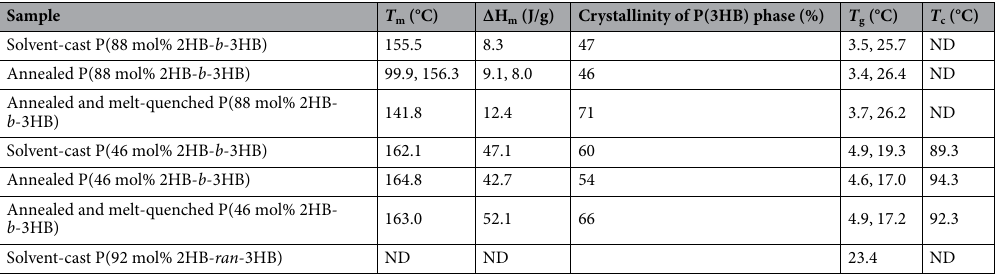
Table 2. Thermal properties of P(2HB- b -3HB) and P(2HB- ran -3HB) films. The annealed films were incubated at 70 °C for 24 h in a heat press machine. The melting temperature ( T m ) and enthalpy of fusion (ΔH m ) were determined in the first heating scan and the glass transition ( T g ) and crystallization temperatures ( T c ) were determined in the second heating scan. The melt-quenched films were incubated at 120 °C for 3 h and − 20 °C for 5 min. ND = not detected.